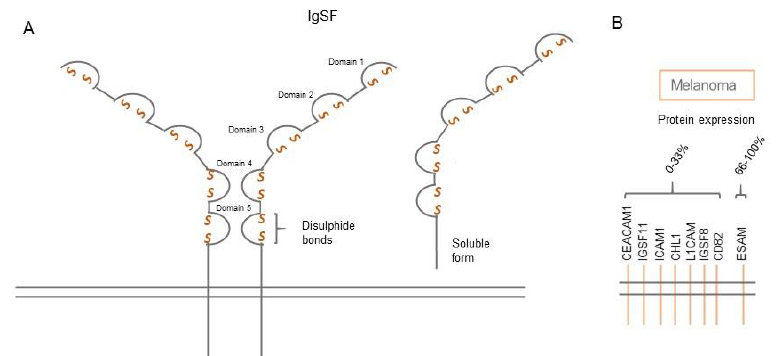
Figure 5. Schematic structure of immunoglobulins and protein expression in melanoma. ( A ) Extra- cellular structure of the immunoglobulin superfamily in the membrane bound and secreted form. ( B ) IgSF protein expression on melanoma cells obtained from the Human Protein Atlas (immuno- histochemistry staining). Staining intensities are estimated based on the percentage of patient sam- ples positively stained for the respective CAM and classified into low (0 – 33% of patients), medium